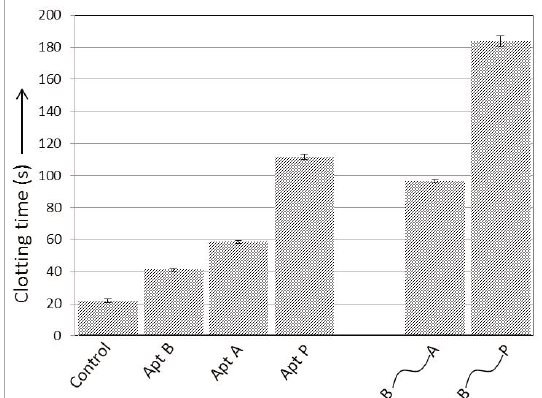
Figure 3. Anticoagulant activity of thrombin-binding aptamers. Apt P demonstrates much better anticoagulant activity than Apt A. Anticoagulant activity improves when the aptamers are linked via a 20-base ssDNA linker, with the B-P pair showing much better anticoagulation than the B-A pair. The concentration of construct in each case is 1 µM. Clotting time is expressed as mean ± SEM.